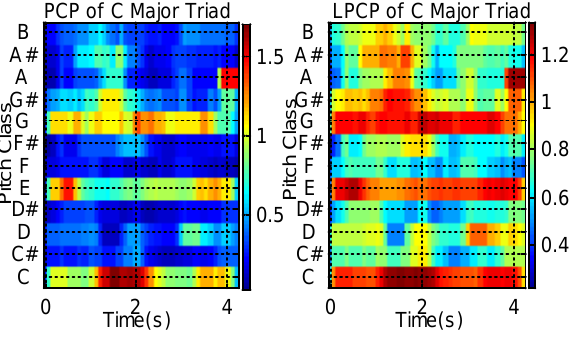
Figure 2. PCP (pitch class profile) ( left ) and LPCP (logarithmic pitch class profile) ( right ) of C major triad.